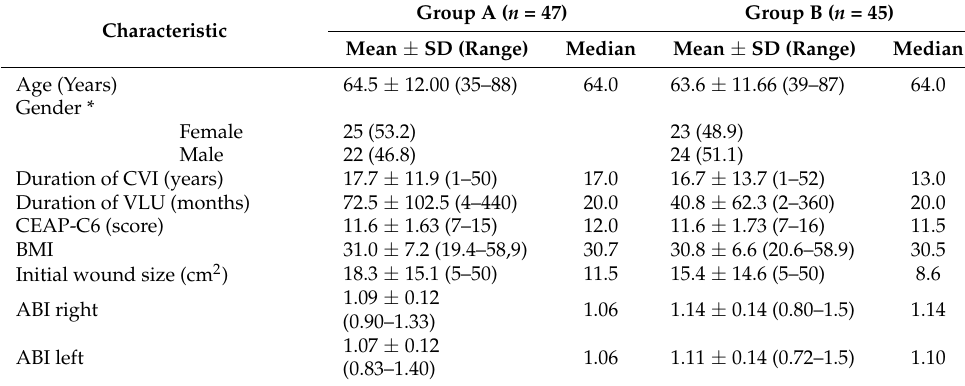
Table 1. Characteristics of the patients included in the